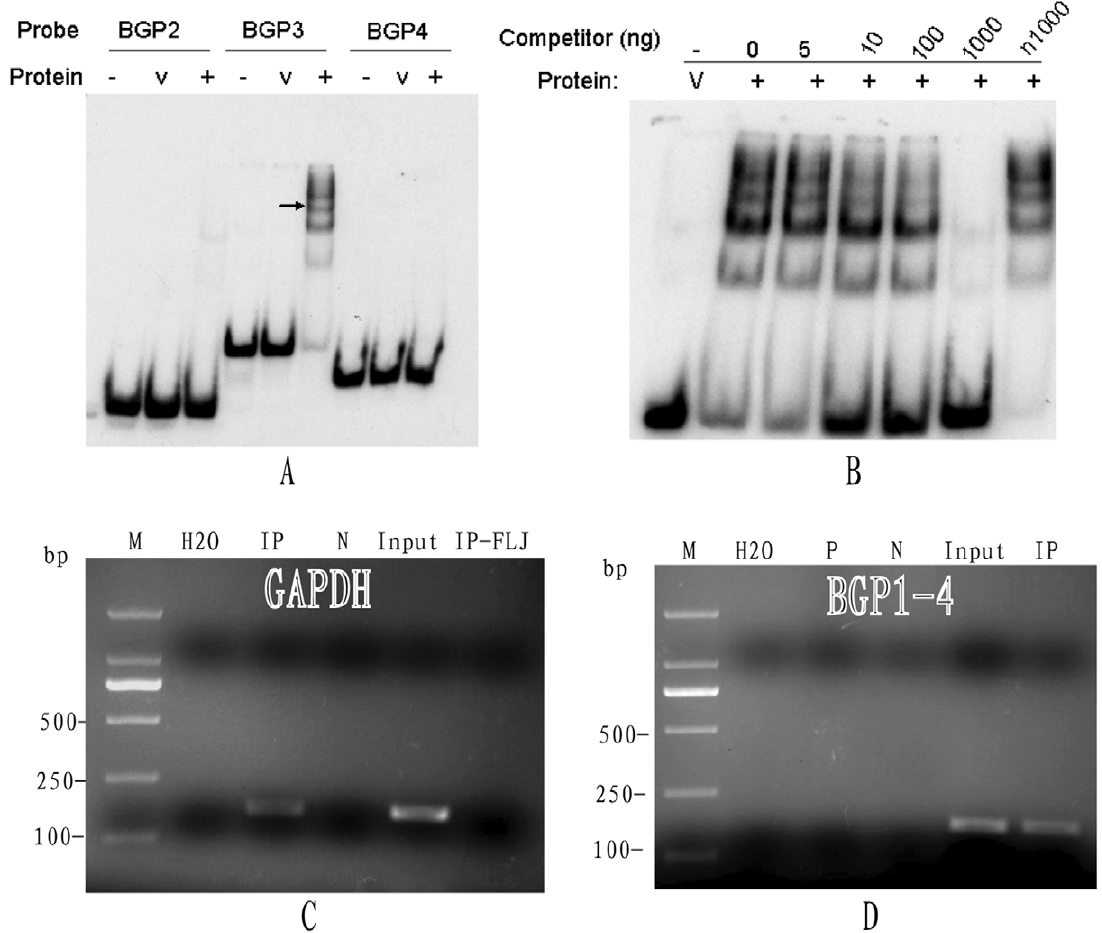
Figure 1. The binding assays of FLJ20420 to the BAG-1 promoter. (A) The BAG-1 promoter was separated into several 30- to 50-bp DNA oligos, which were used as probes to perform EMSAs with purified GST-FLJ20420 fusion protein ( + ). Purified GST protein was used as a control (v). (B) EMSA competition test. Unlabeled specific DNA fragments (i.e., 100 ng and 1000 ng), and not the non-specific fragment (i.e., n1000) effectively compete for FLJ20420 binding. (C) Immunoprecipitation of crosslinked protein/DNA with anti-acetyl histone H3 antibody was first performed, and then purified DNA was analyzed by PCR using the control primers (GAPDH). M: DNA ladder; H 2 O: water; IP: immunoprecipitation with anti-acetyl histone H3 antibody; N: negative control, immunoprecipitation with normal rabbit IgG antibody; Input: mixed DNA; IP-FLJ: immunoprecipitation with anti-human FLJ20420 antibody. (D) Immunoprecipitation of crosslinked protein/DNA with anti-human FLJ20402 antibody was first performed, and then purified DNA was analyzed by PCR using BAG-1 promoter-specific primers (BGP1-4). M: DNA ladder; H 2 O: water; P: immunoprecipitation with anti-acetyl histone H3 antibody; N: negative control, immunoprecipitation with normal rabbit IgG antibody; IP: immunoprecipitation with anti-human FLJ20420 antibody; Input: mixed DNA.